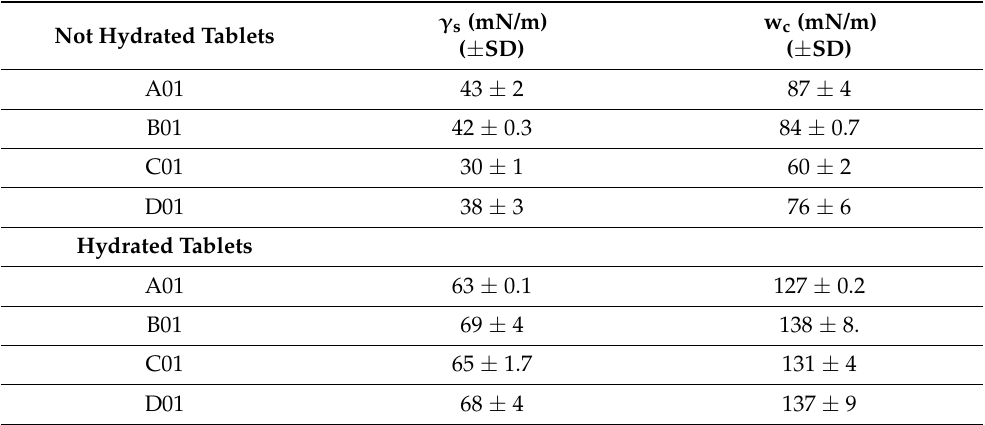
Table 5. Surface energy ( γ s ) ( ± SD) and cohesion work (w c ) ( ± SD) of mucin tablets hydrated and not hydrated.